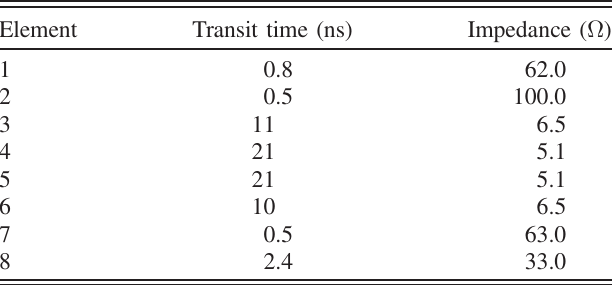
TABLE II. Transit time in nanosecond and impedance in ohm for the transmission line elements in IS.